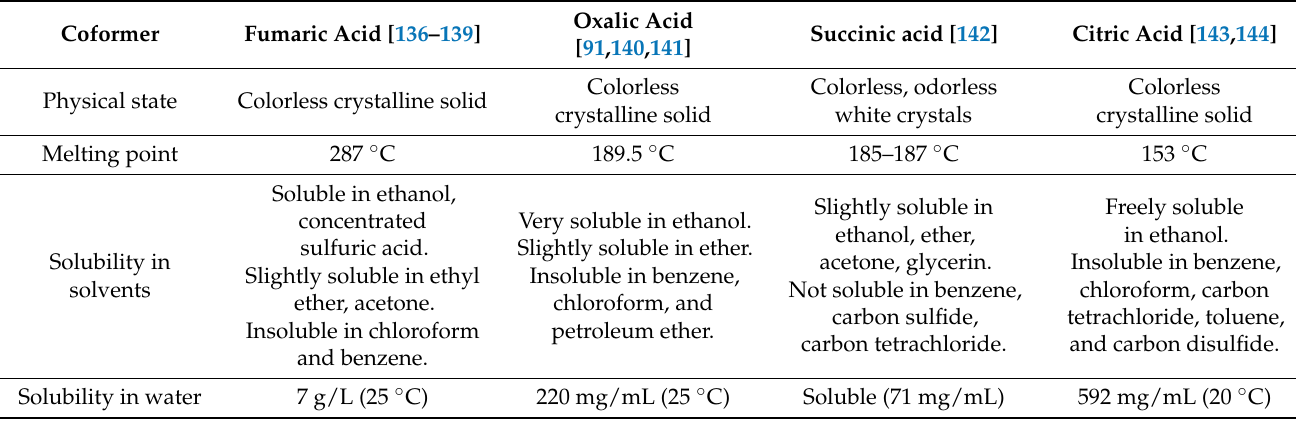
Table 7. Physical and chemical properties of carboxylic acid ‐ based coformers.